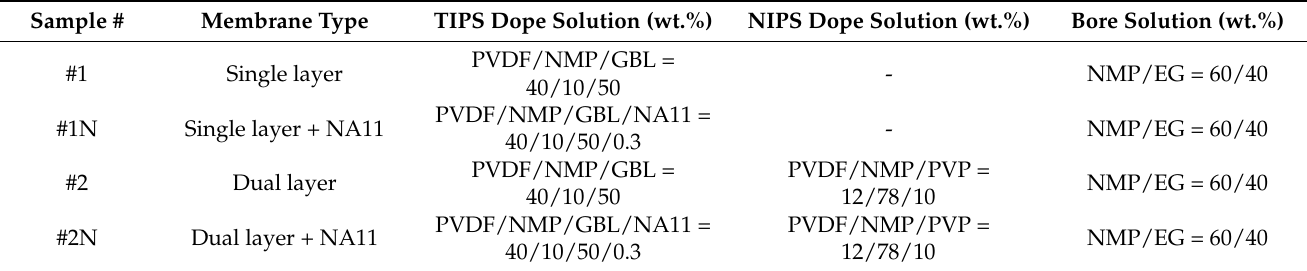
Table 1. Dope solution composition of the single and dual layer membrane.